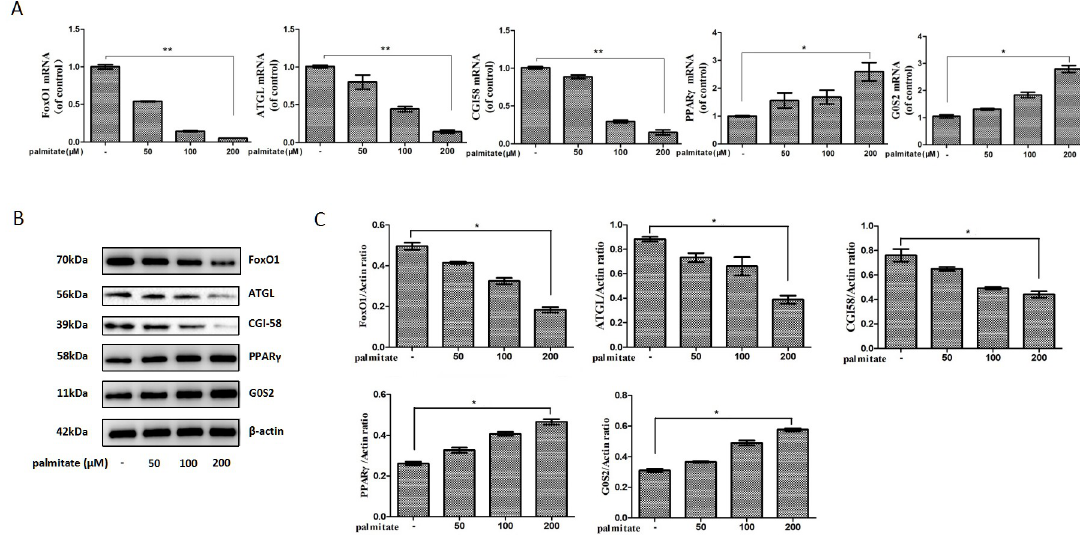
Fig 2. Palmitate reduced FoxO1, ATGL and CGI-58 and increased PPAR γ and its target gene G0S2 expression in HepG2 hepatocytes in a concentration-dependent manner. (A) Palmitate reduced FoxO1, ATGL and CGI-58 but increased PPAR γ and G0S2 mRNA expression. The mRNA levels were determined by a quantitative PCR analysis and were normalized to β -actin. (B) Palmitate reduced FoxO1, ATGL and CGI-58 and increased PPAR γ and G0S2 protein expression. The protein expression levels were determined by a Western blot analysis. (C) The bands were quantified and normalized relative to β -actin. Each bar represents the means ± SDs (n = 3). � P < 0.05, �� P < 0.01.